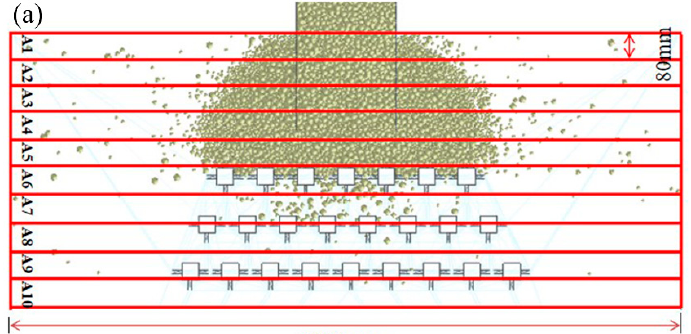
Figure 19. The product shape modification and transformation process.